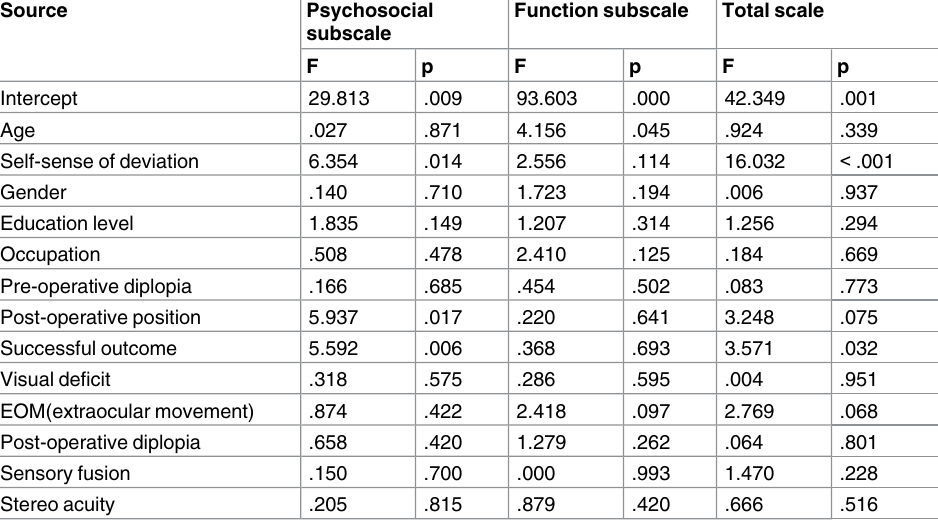
Table 4. Factors associatedwith